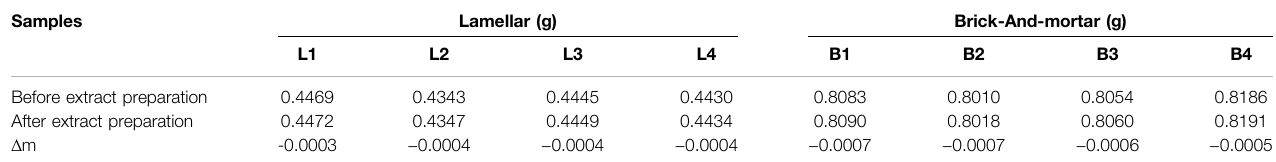
TABLE 1 | Weight changes before and after sample extract preparation. Samples